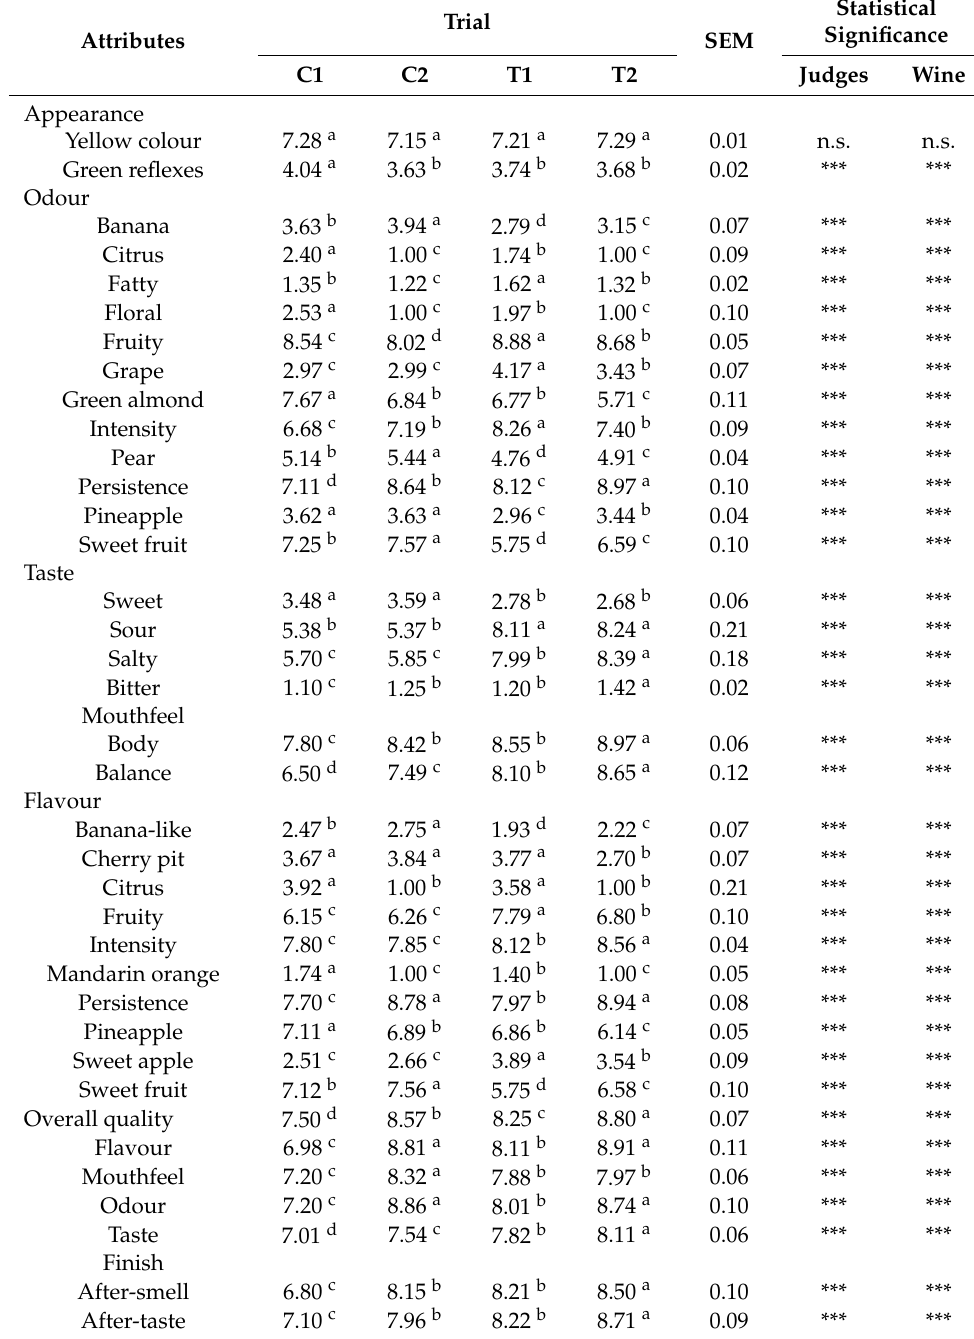
Table 3. Sensory score for experimental Catarratto wines. Attributes